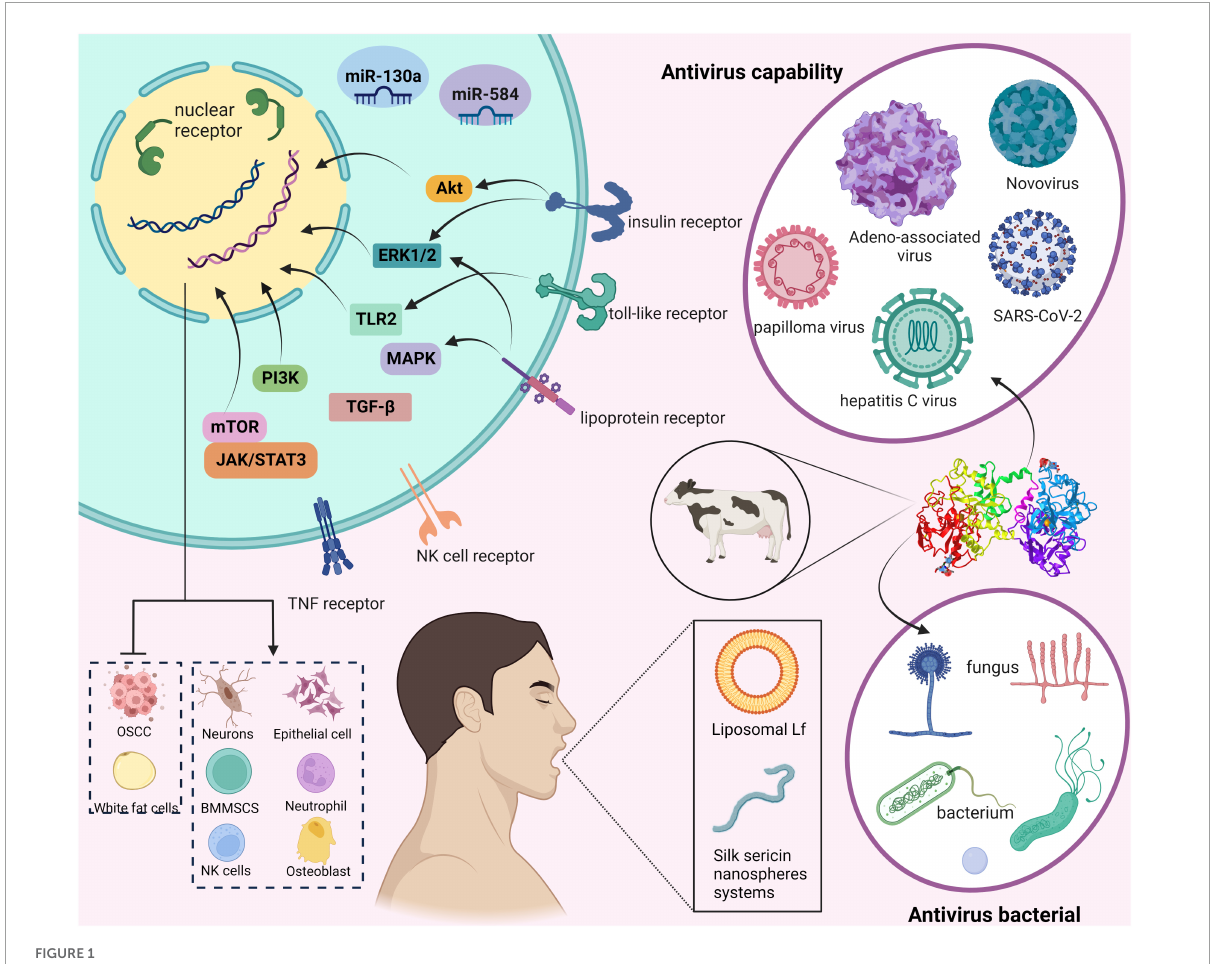
FIGURE1 Overview of this review of lactoferrin